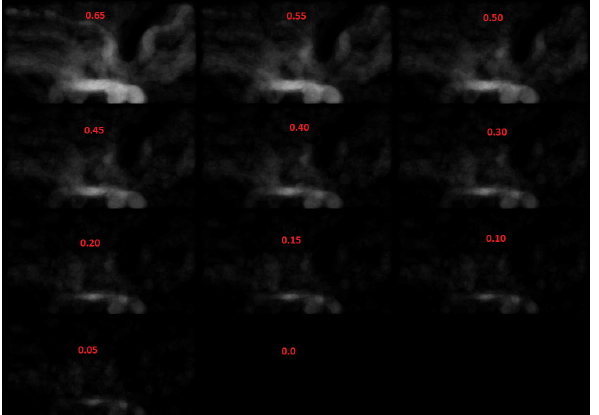
Figure 9. The results of applying the gas leak detection on the collected data from Experiment A and B.